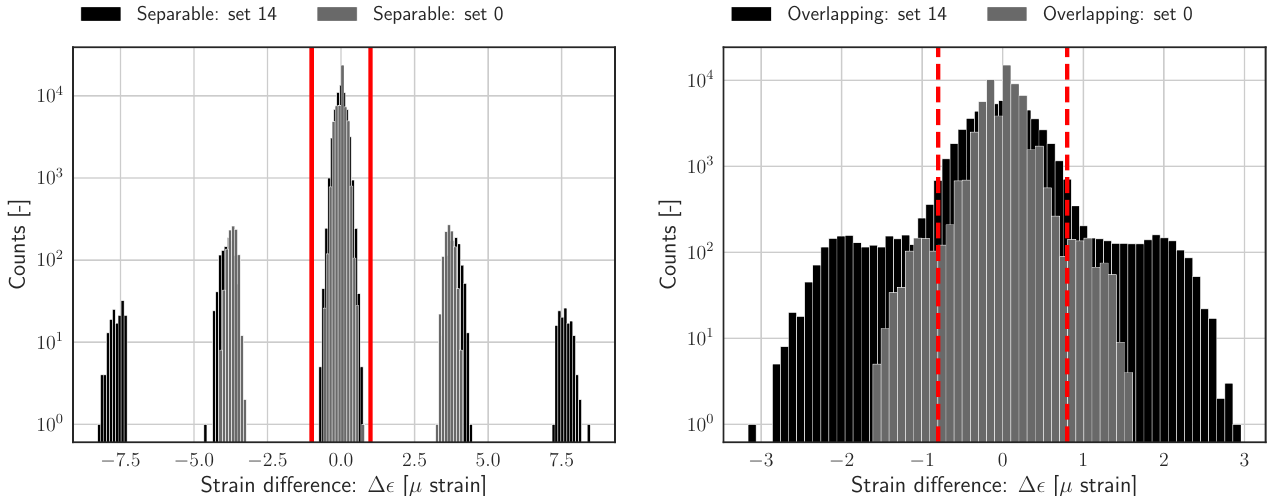
Figure 4. Left : separable histograms for two time series, with clear gaps between clusters belonging to nominal and shifted samples, as well as exact domain boundaries (red lines); set 14 contains 4 outlier clusters (black), whereas set 0 contains 2 outlier clusters (grey). Right : overlapping histograms for two time series with obvious overlap between clusters, and estimated domain boundaries (red); notable difference between the range and the shape of the histogram belonging to set 14 and set